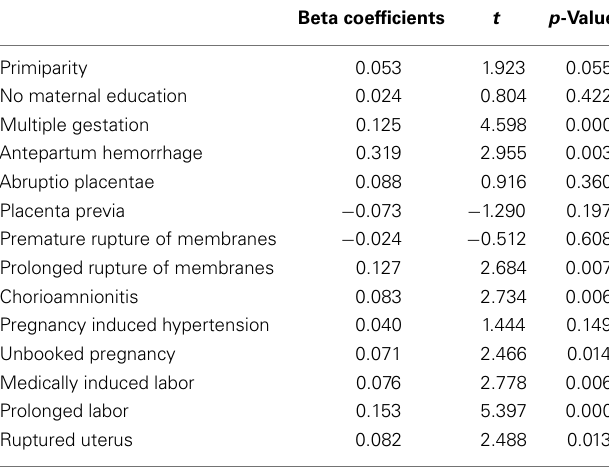
Table 5 | Maternal risk factors of perinatal deaths .